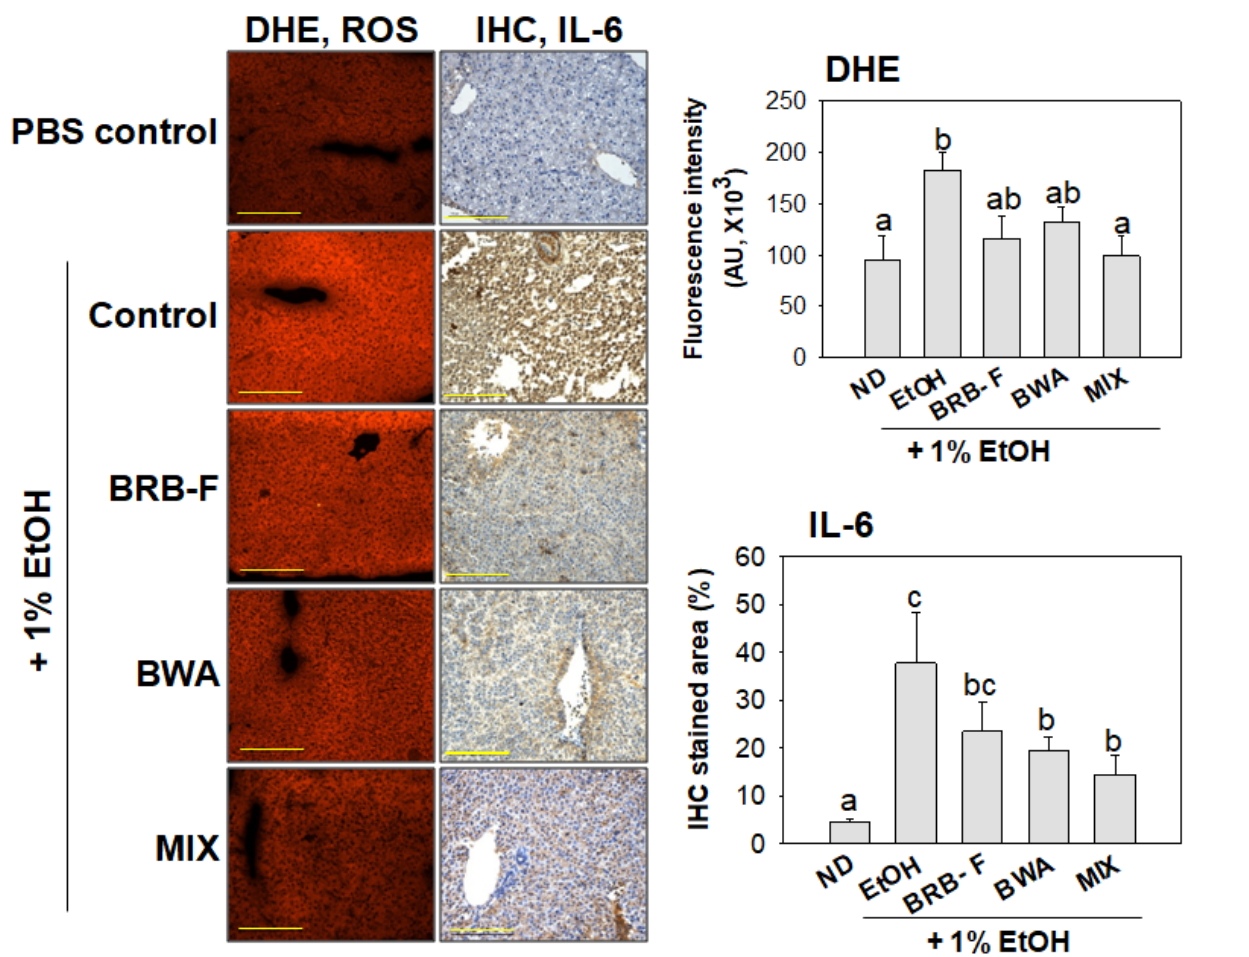
Figure 4. Effect of BRB-F, BWA, and MIX in alcohol liver injury zebrafish for 10 days on hepatic histology for reactive oxygen species production and IL-6 expression (400×, Scale bar: 100 µm). The data are the mean ± SEM; a,b,c mean values with different superscript letters are significantly different among all groups ( p < 0.05); PBS, zebrafish exposed to 1% PBS, n = 20; EtOH, zebrafish exposed to 1% ethanol, n = 20; BRB-F, EtOH fed 10% black rice bran, n = 20; BWA, EtOH fed 10% beeswax alcohol, n = 20; MIX, EtOH fed a mixture of BWA and BRB-F (1:6, w / w ), n = 20; DHE, dihydroethidium; IL-6, interleukin-6; IHC, Immunohistochemistry. DHE- and IL-6-stained transverse section of the liver; representative photomicrographs of the liver are shown at 400× magnification. The scale bar indicates 100 µm.